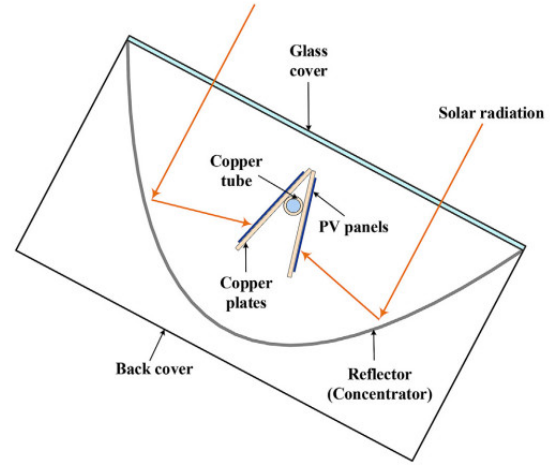
Figure 9. The cross-sectional view of CPVT system tested in [90].